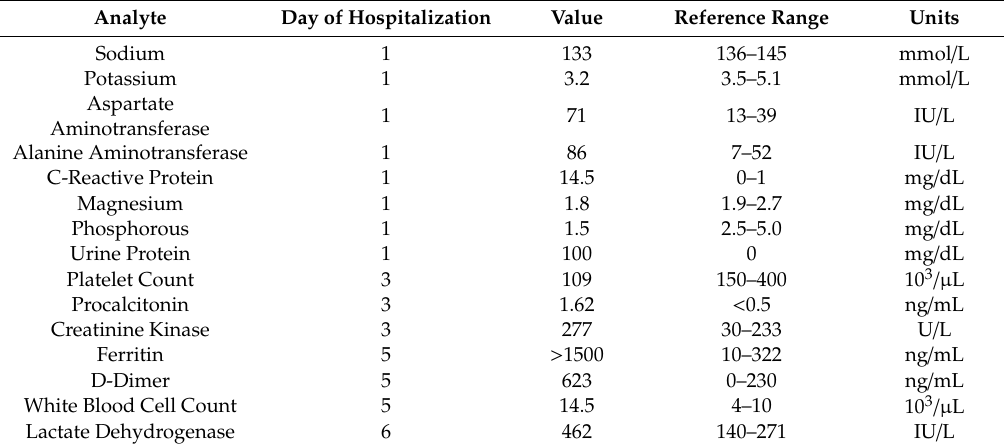
Table 1. Abnormal laboratory findings of the case